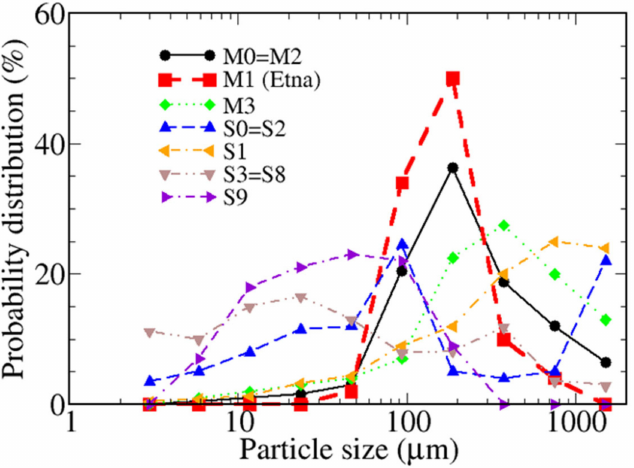
Figure 5. Probability distribution in a semi-logarithmic scale of particle sizes of volcanic ash emitted by Etna (M1) [6] compared with other classes of